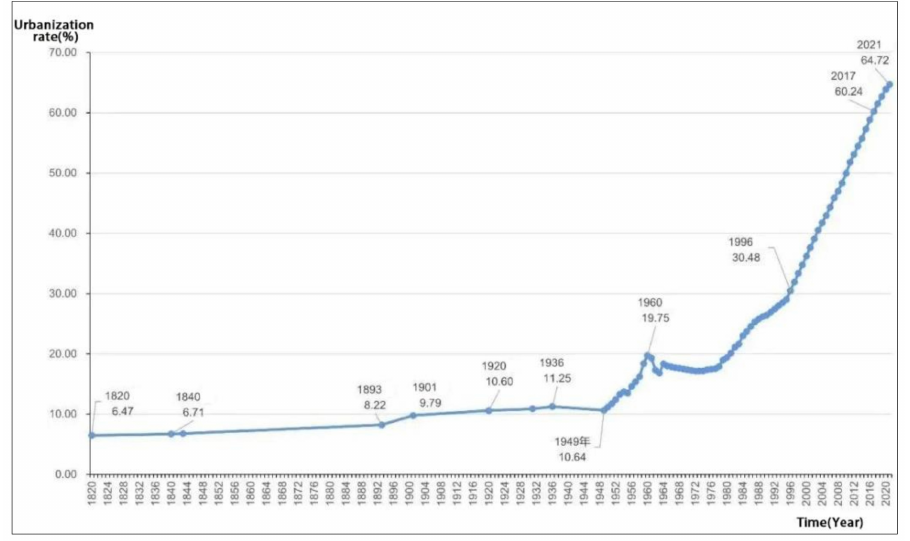
Figure 1. Changes in China’s urbanization rate since